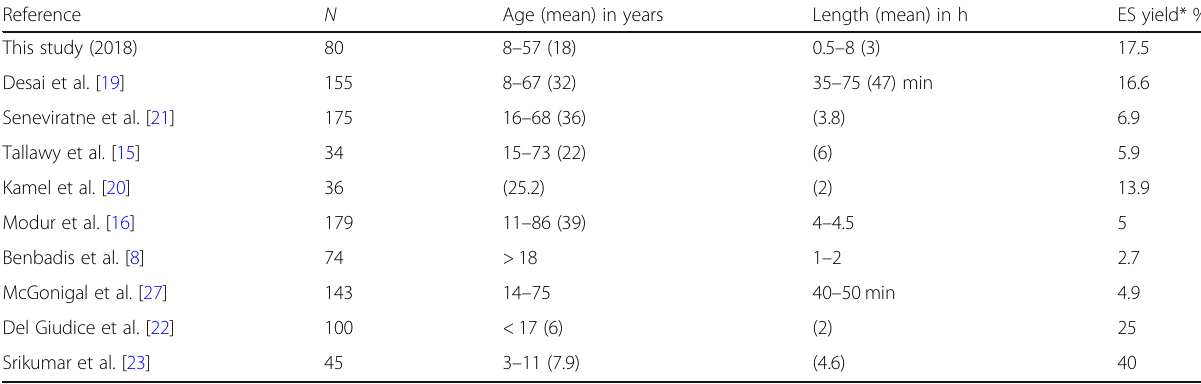
Table 4 Comparison of short-term video EEG monitoring studies regarding its diagnostic yield Reference